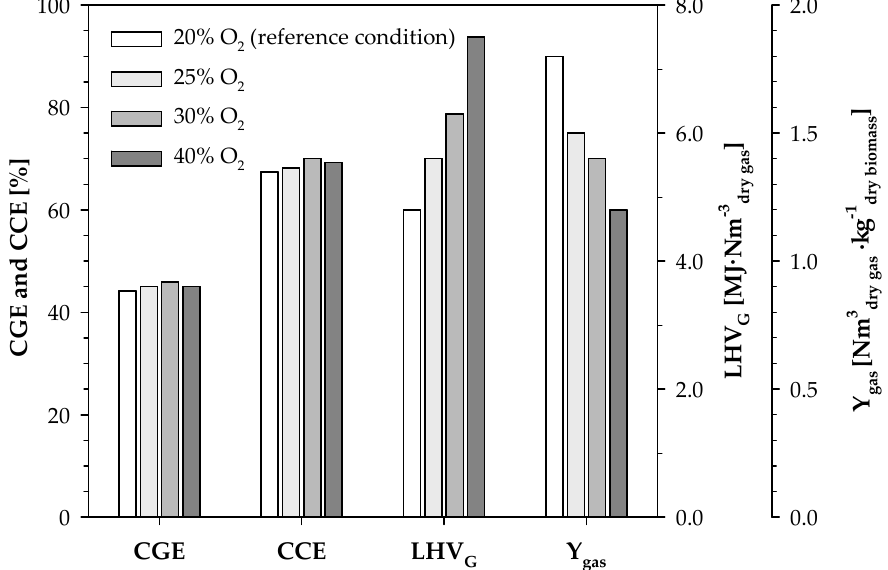
Figure 8. Effect of O 2 concentration ( ϕ ) in gasification agent on the LHV G and performance parameters during air gasification of RFB from eucalyptus (SBR = 0.0 kg steam · kg − 1 biomass —Tables 3 and 4).